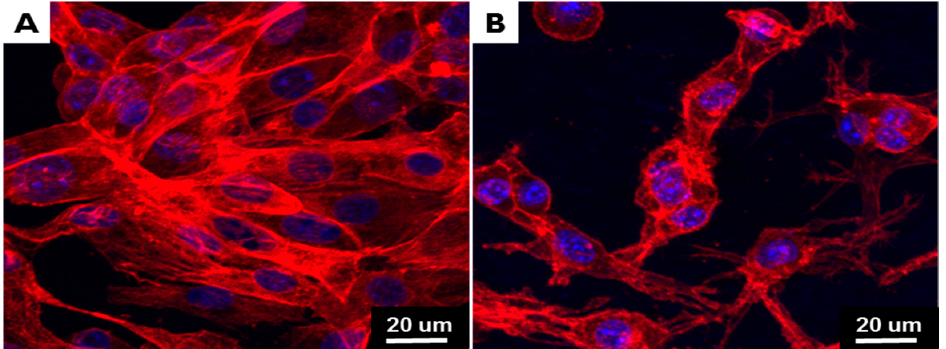
Figure 6. Immunofluorescent staining images of adherent NIH3T3 cells obtained by confocal microscopy: ( A ) CM; and ( B ) EI-BCM. NIH3T3 cell on EI-BCMs ( B ) had a long and straight F-actin similar to the CM.